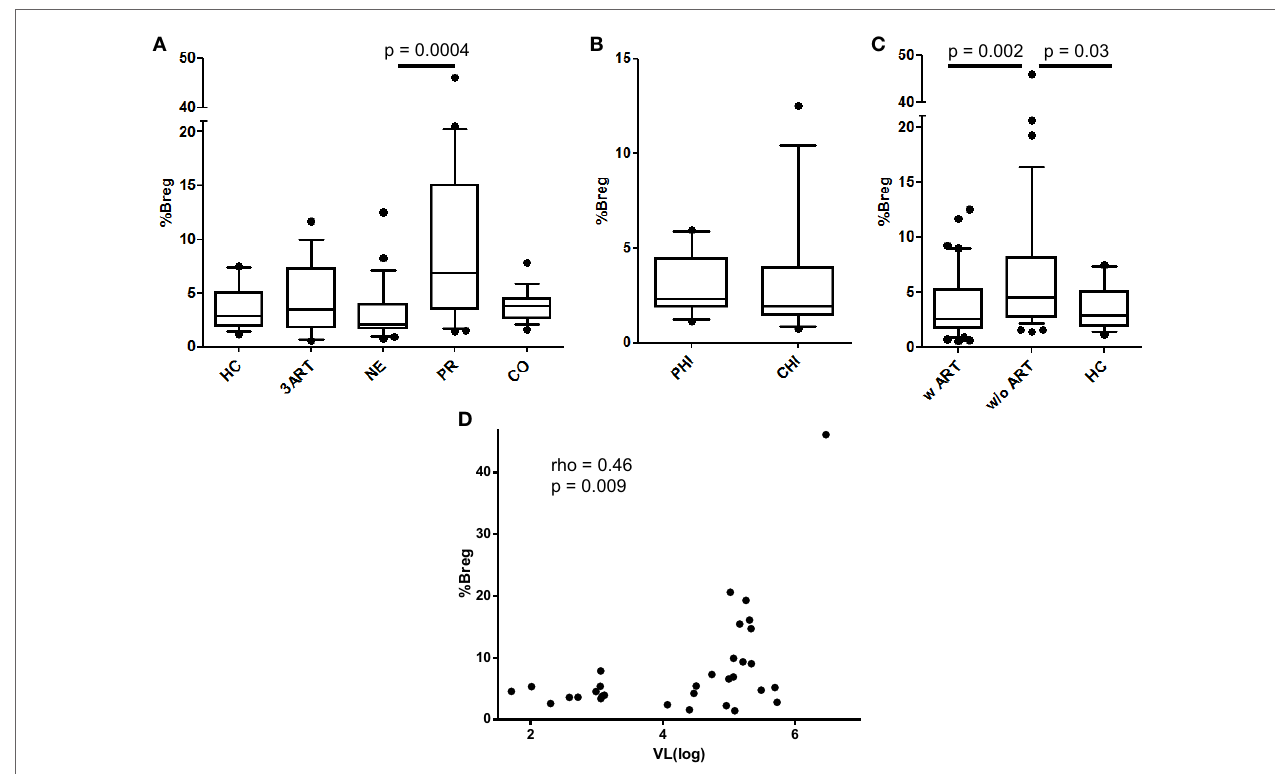
FigUre 3 | Regulatory B cell (Breg) levels and correlation of their frequencies with viral load (VL). (a) There was no difference in the Breg frequencies between the New Era (NE) and 3ART patients, but the NE patients showed significantly lower Breg frequencies than progressors (PR) ( p = 0.0004). (B) Again, there were comparable frequencies in the subgroups primary HIV infection (PHI) and chronic HIV infection (CHI) ( p = 0.46). (c) The Breg levels of the patients with antiretroviral therapy (w ART) were significantly decreased compared with those w/o ART ( p = 0.002) and were similar to the HIV-uninfected controls (HC) group. (D) The Breg frequencies directly and significantly correlated with the VL of the viremic HIV-infected patients of our cohort (rho = 0.46, p = 0.009) [HC: n = 16; 3ART: n = 16; NE: n = 24 (PHI: n = 10; CHI: n = 14); PR: n = 21; CO: n =